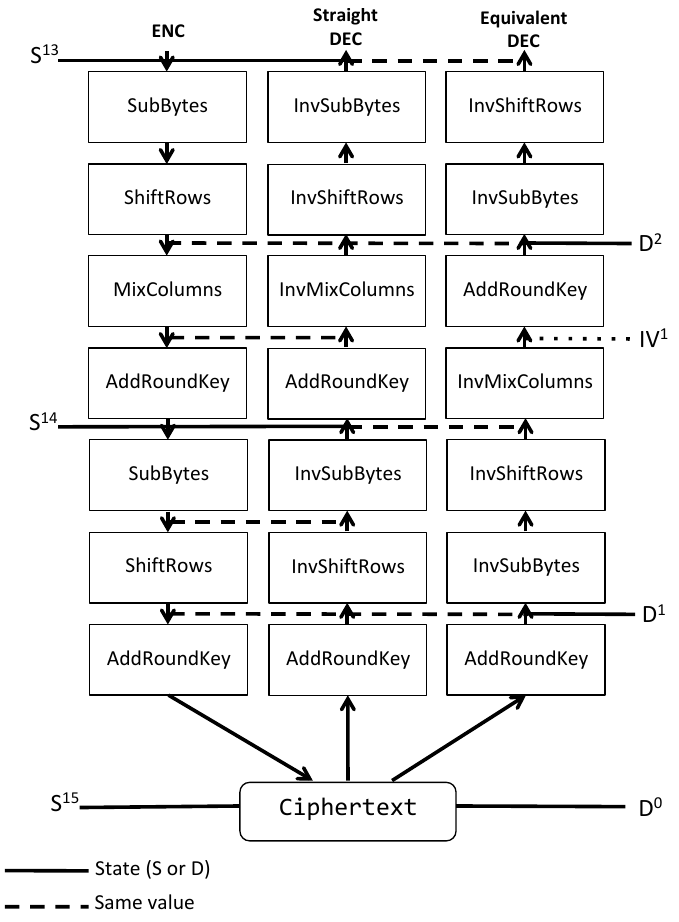
Figure 4. Relation between encryption, straight decryption and equivalent